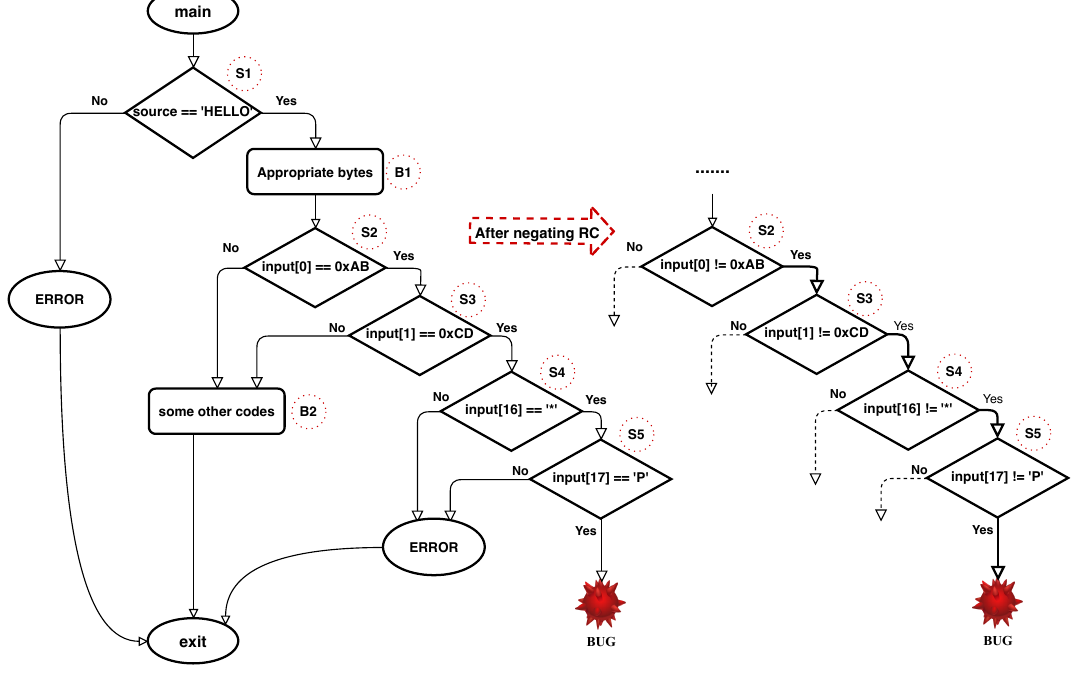
Figure 2. CFG of Listing 1 and after transforming